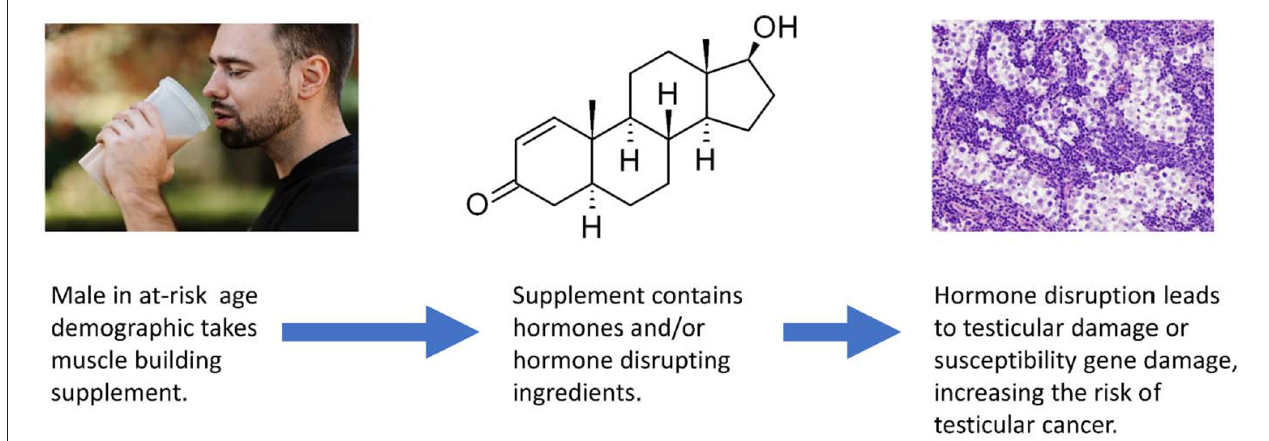
FIGURE 1 | An illustration of MBS increasing testicular cancer risk by hormone